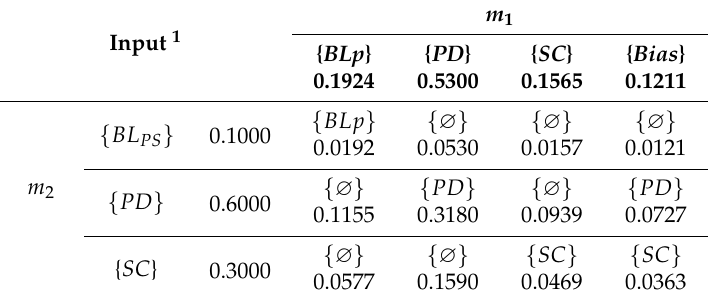
Table 3. Calculation of mass value